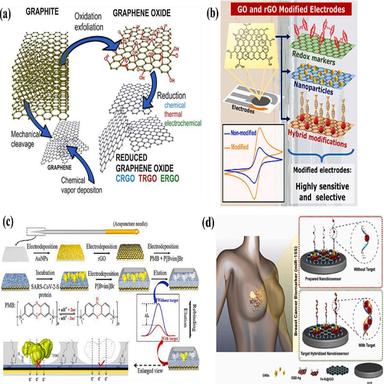
(a) A schematic for the possible ways for preparation of rGO from graphite. Reproduced with permission , (b) Various possibilities of preparation of GO and rGO based biosensors. Reproduced with permission, (c) Construction of the miniature electrochemical biosensing platform and its use for SARS-CoV-2-S protein quantification. Reproduced with permission and (d) Fabrication of biosensing platform by using functionalized/conjugated graphene and gold nanostars and its application t